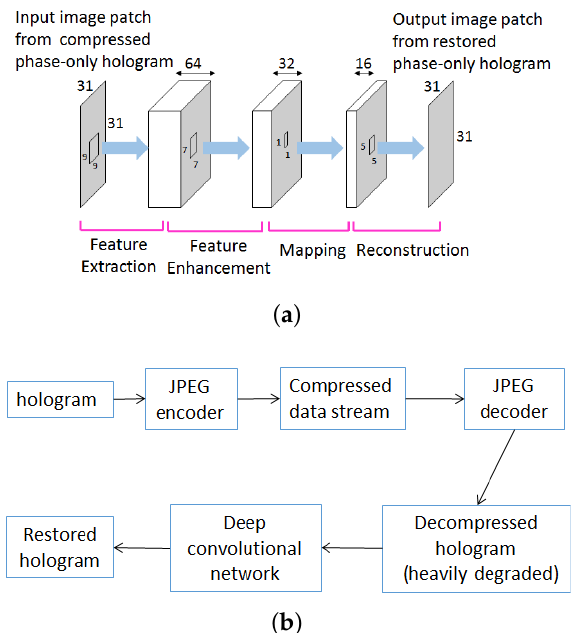
Figure 4. ( a ) Structure of deep convolutional network for the quality enhancement of JPEG compressed holograms in our work; and ( b ) overall flowchart of our proposed “JPEG+deep learning” hologram compression